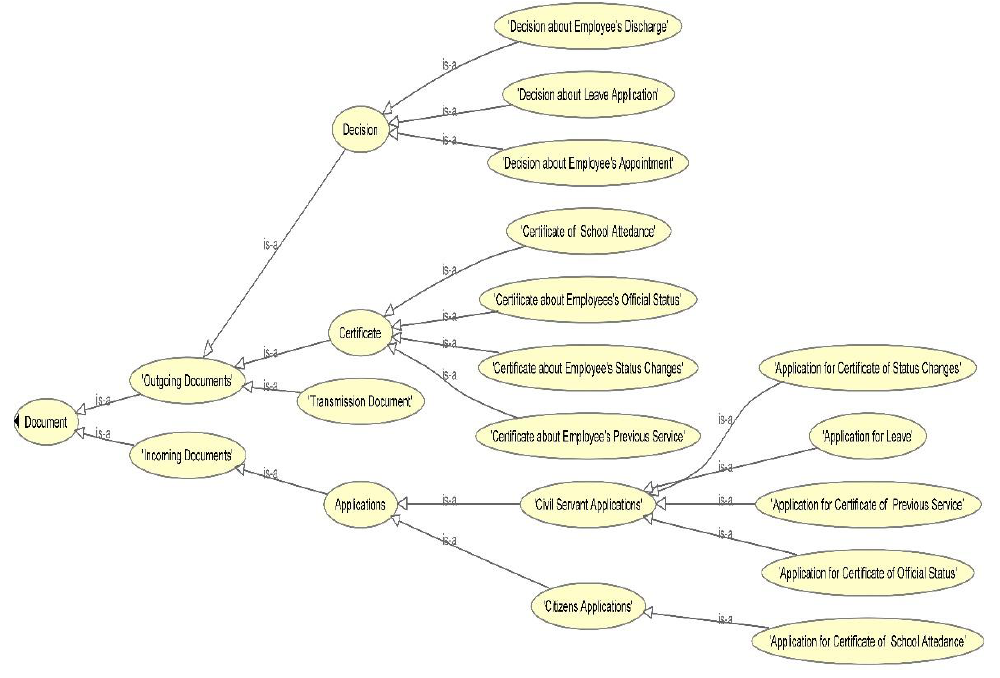
Figure 3. The Document class hierarchy.